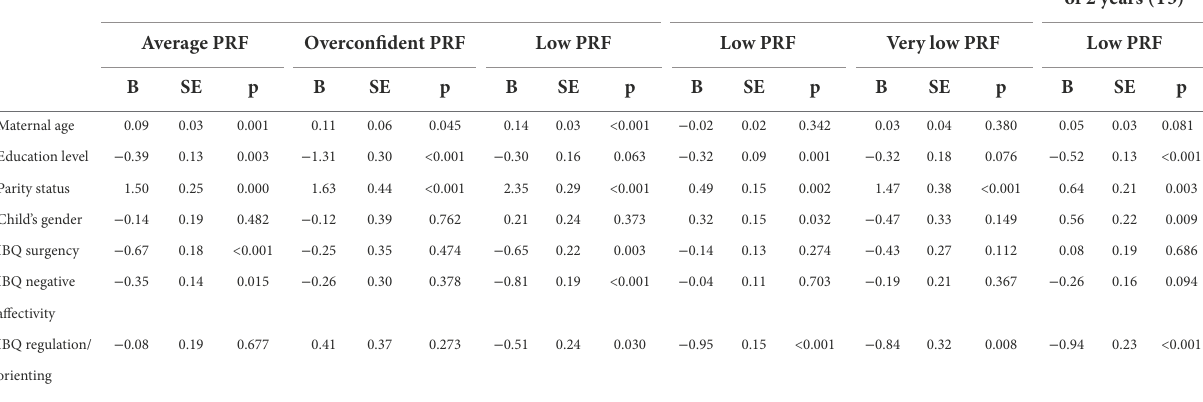
TABLE 3 Predictors of membership in the cross-sectional latent PRF profiles.